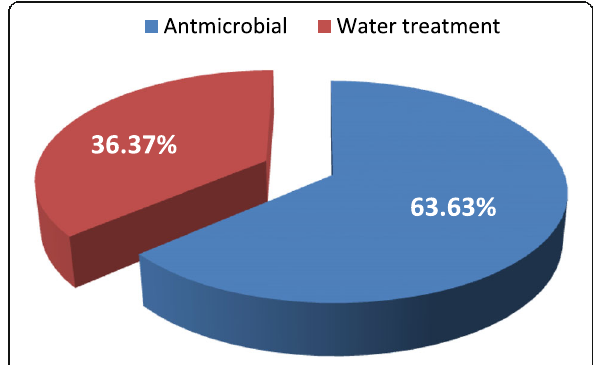
Fig. 4 Frequency (%) of reported antimicrobial activity of